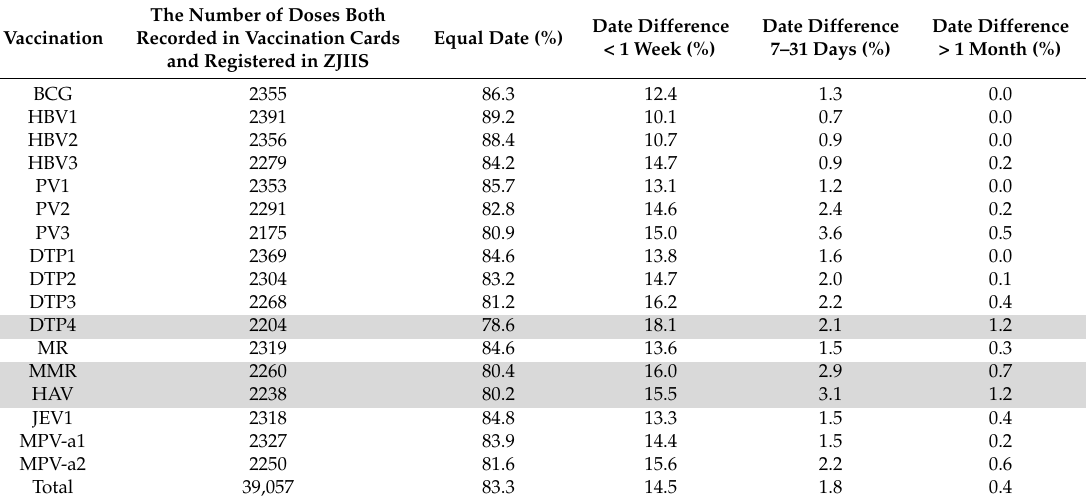
Table 4. Accuracy of administration dates in